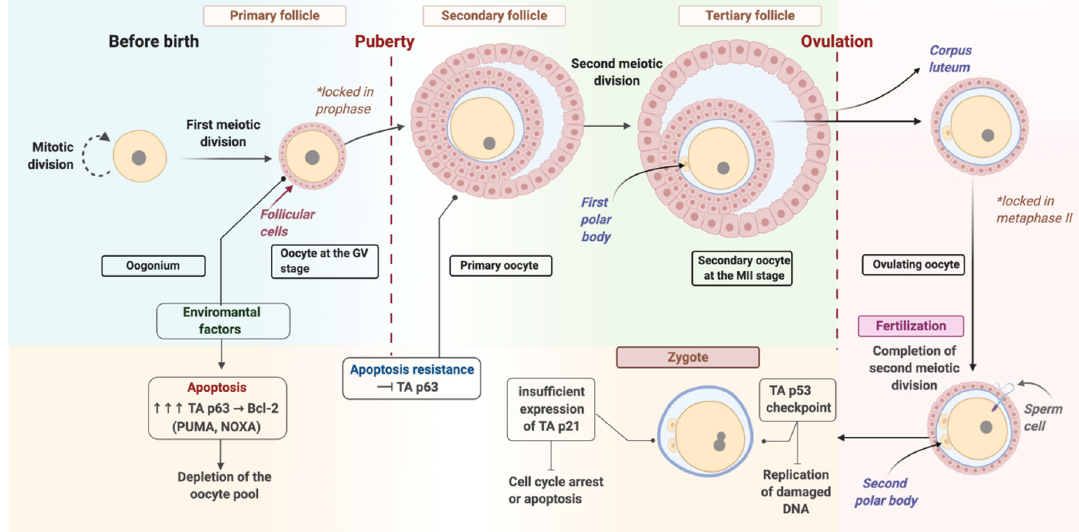
Figure 1. The process of differentiation in female germ cells. Created with BioRender.com.